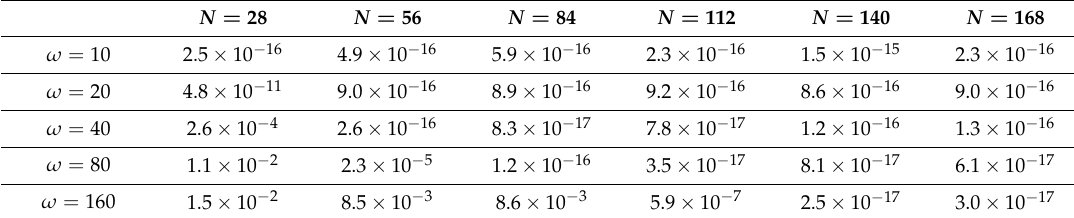
Table 7. Absolute errors of JJE for Example 3.